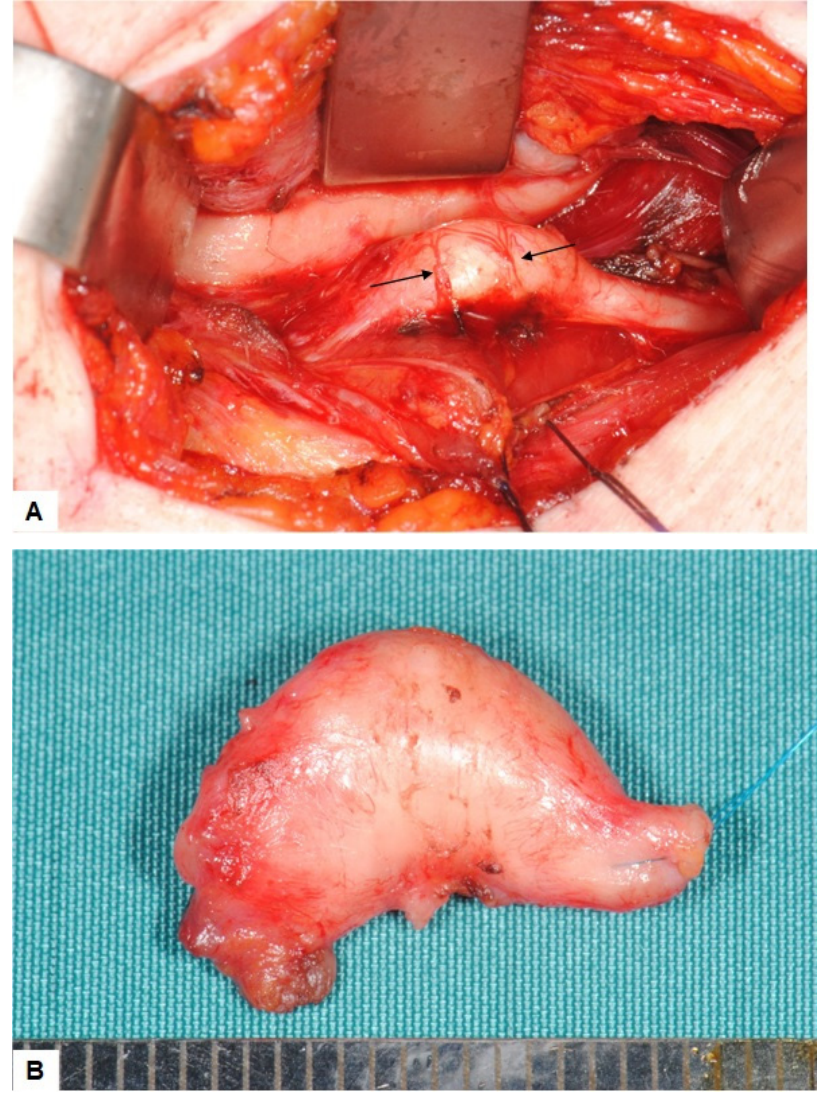
Figure 4. ( A ) Intraoperative findings: The tumor appears as a swelling of the hypoglossal nerve. As suggested by ultrasound findings, small vessels cross the surface. No adhesion to the surrounding tissues and especially no adhesion to the mylohyoid muscle is found. ( B ) Resection specimen: The tumor appears fully encapsulated by the perineurium When sectioned, there is no demarcation be ‐ tween the nerve and the tumor.